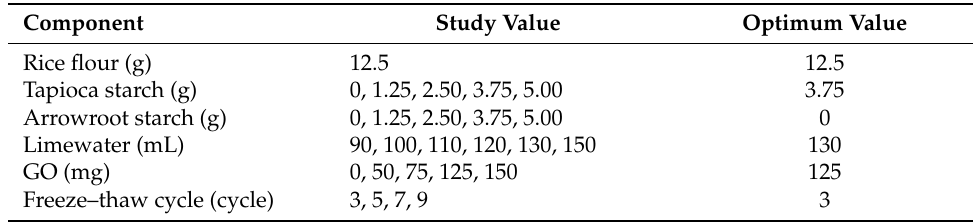
Table 1. Optimum conditions to prepare